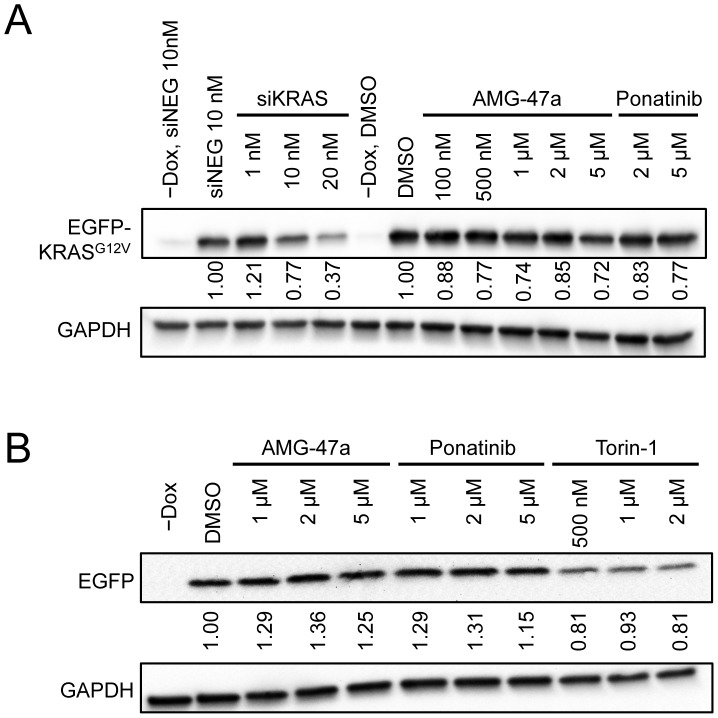
Validation of hit compounds by western blot.
A. Levels of EGFP-KRASG12V protein in HeLa cells treated with a KRAS siRNA (siKRAS), AMG-47a and Ponatinib were probed with KRAS antibody in whole cell lysates. Numbers below the blot indicated relative protein levels. The siKRAS treated samples were normalized to siNEG control, and the compound treated samples were normalized to DMSO control. B. Levels of EGFP protein in HeLa cells treated with AMG-47a, Ponatinib and Torin-1 were probed with EGFP antibody in whole cell lysates. Numbers below the blot indicate relative protein levels normalized to DMSO control.